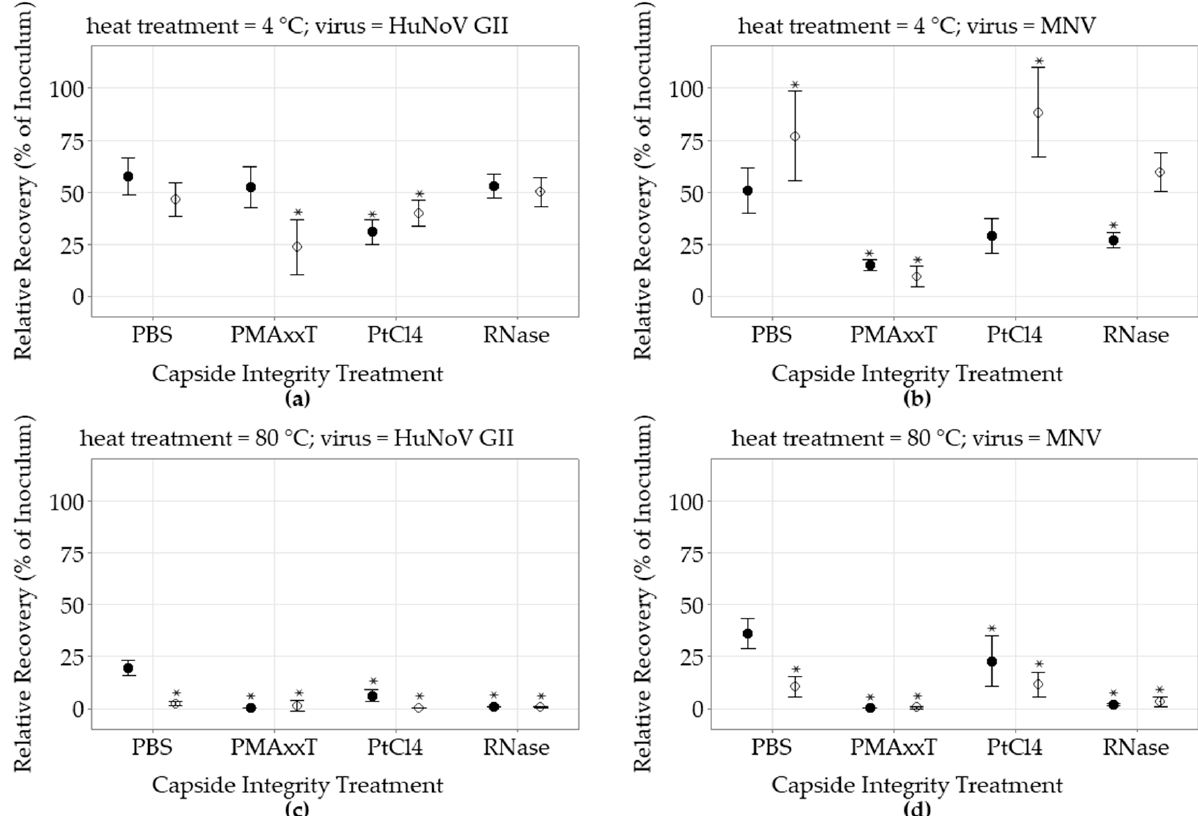
Figure 2. Impact of capsid integrity treatment on heat-treated norovirus recovery following ISO 15216-1:2017 extraction from spiked lettuce . Viruses were heat treated for 5 min or left untreated; ( a ) non heat treatment (4 °C) HuNoV GII ; ( b ) non heat treatment (4 °C) MNV; ( c ) heat treatment (80 °C) HuNoV GII; ( d ) heat treatment (80 °C) MNV. Following heat treatment, the viruses were